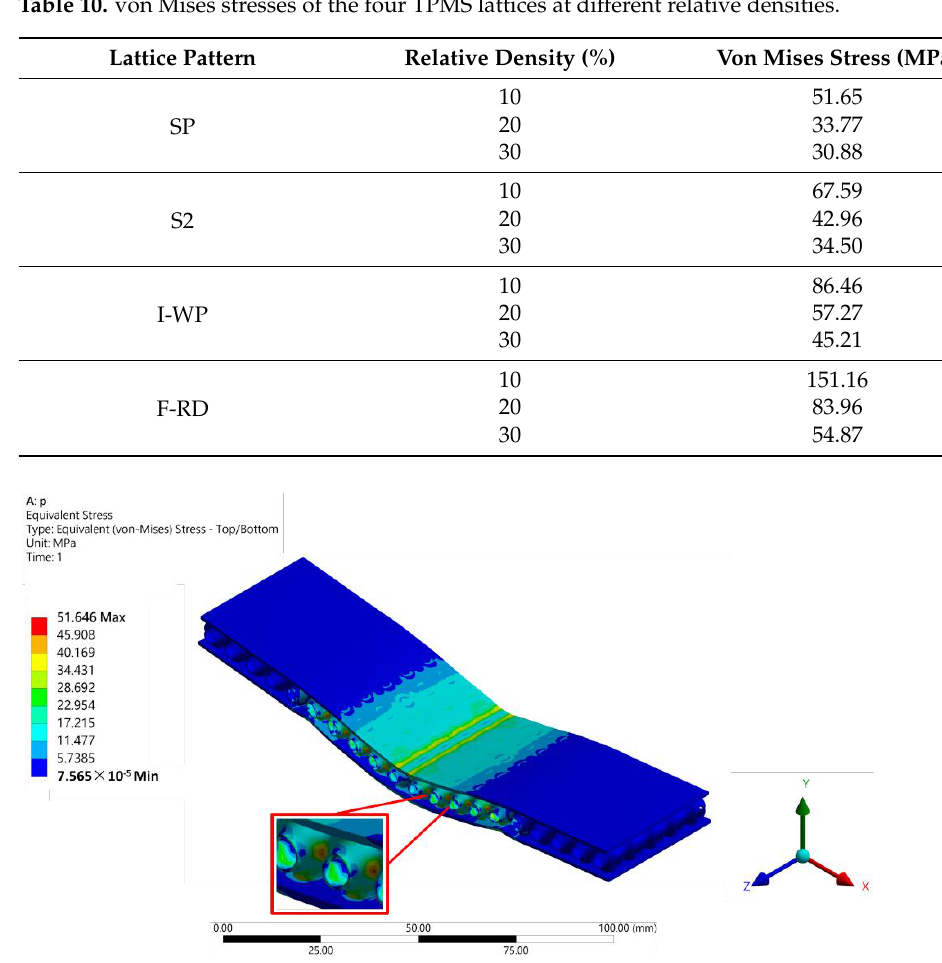
Figure 13. Stress distribution of the SP lattice core inside the SPS.